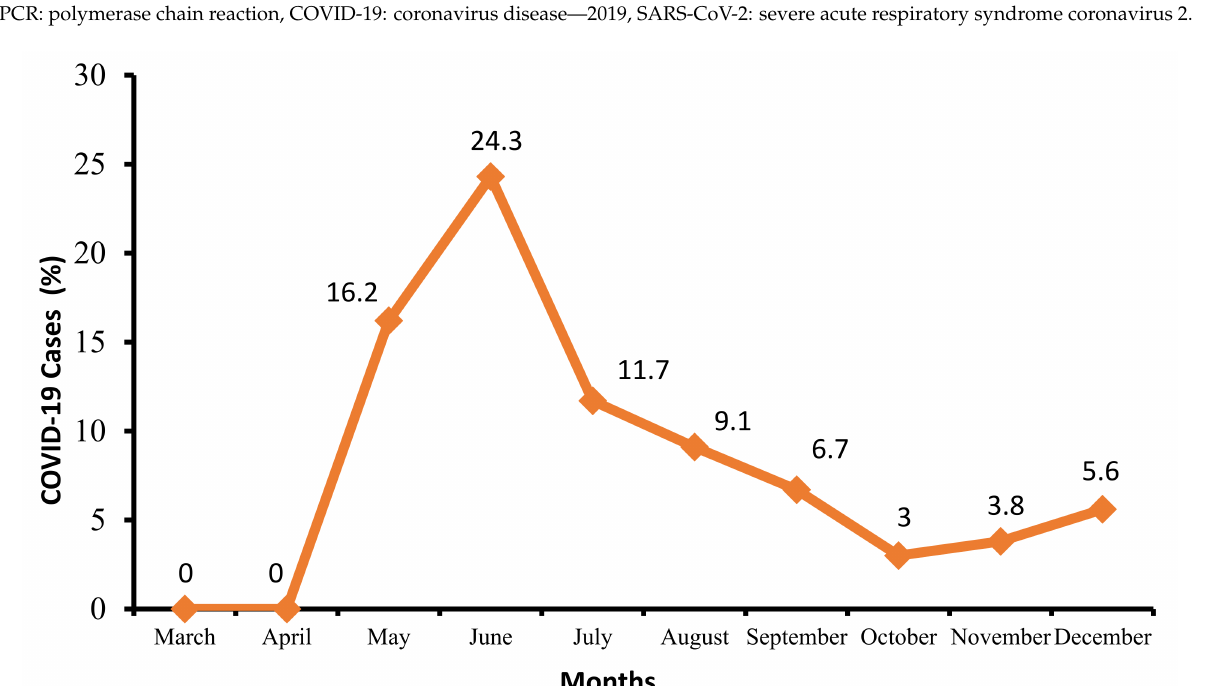
Number SARS-CoV-2 Positive Tests Healthcare Workers